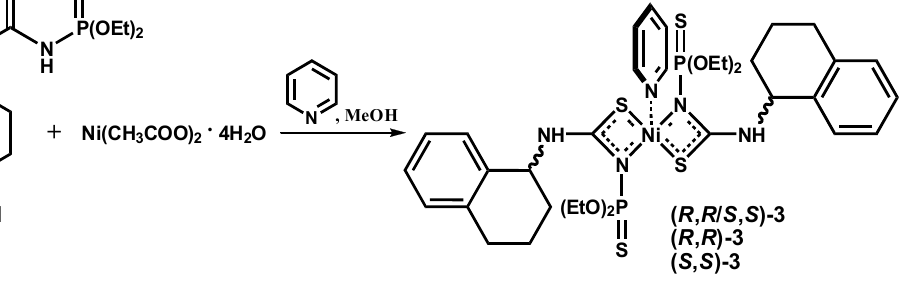
Scheme 2. The synthesis of square-planar complexes 2 .